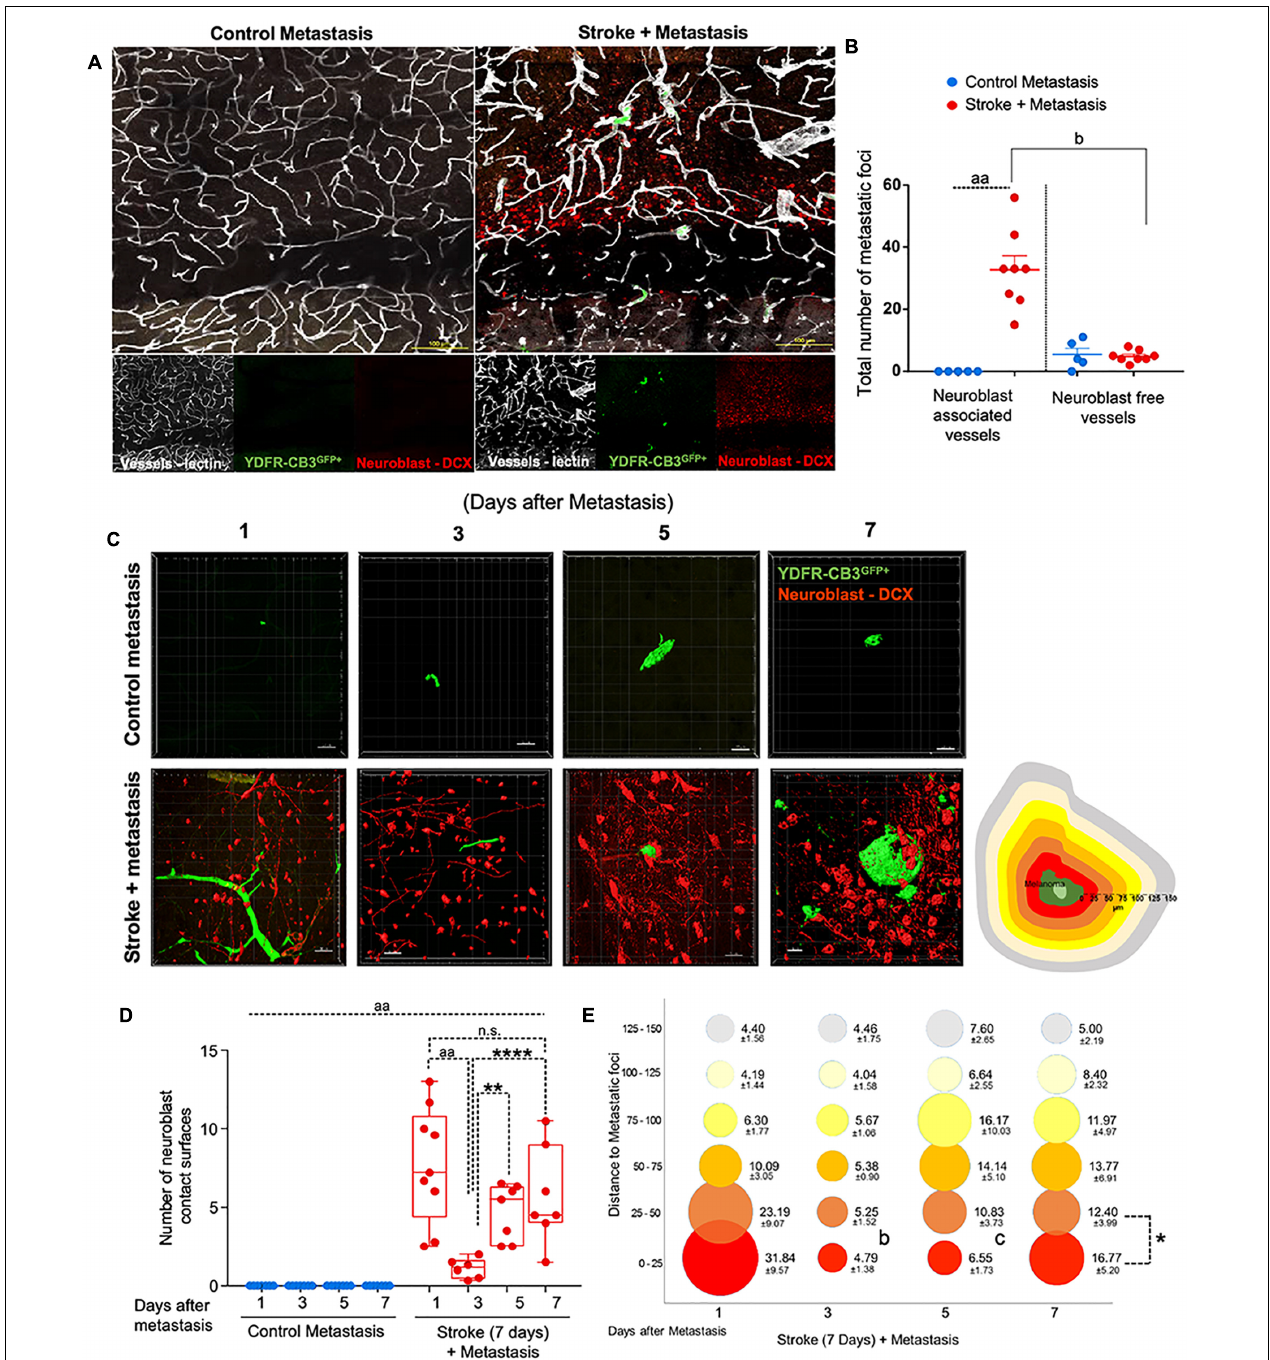
FIGURE 2 | Repair augments direct cellular interactions between the metastatic cell and neurovascular niche. (A) Immunohistochemical analysis of metastatic melanoma cells shown as GFP + green, lectin-labeled vasculature in white and DCX + neuroblasts in red. (B) Quantitative analysis of metastatic cell interaction with vessels associated with or without neuroblasts shown as scatter plot with mean ± SEM ( n = 5–8, four sections/animal, aa p < 0.0001; b p = 0.0354, Kruskal–Wallis, one-way ANOVA, Dunn’s for multiple comparisons). (C) Representative brain images of metastatic foci (GFP + ) and neuroblasts (RFP + ) over time (left). Control groups did not associate with neuroblasts in the corresponding brain region. Schematic representation of distance bins (25 µ m intervals) used to analyze neuroblast distribution around metastatic foci. Bin closest to melanoma is shown in bright red and increasing distances showing in gradients of yellow and the farthest depicted in gray (right). (D) Box and scatter plot showing number of neuroblast contact surfaces interacting with metastatic foci. Mean ± SEM ( n = 6–9, ∗∗ p = 0.0092, ∗∗∗∗ p = 0.0006, aa p < 0.0001; one-way ANOVA, Holm-Sidak post hoc test used for multiple comparisons). (E) Bubble plot depicting density and distribution of neuroblasts around metastatic foci at 25 µ m distances Mean ± SEM ( n = 5–8, b p = 0.033, c p = 0.033, ∗ p < 0.0164; one-way ANOVA, Holm-Sidak post hoc test used for multiple comparisons). Bubble size represents number of neuroblasts and increasing distances are color coded as shown in schematic.